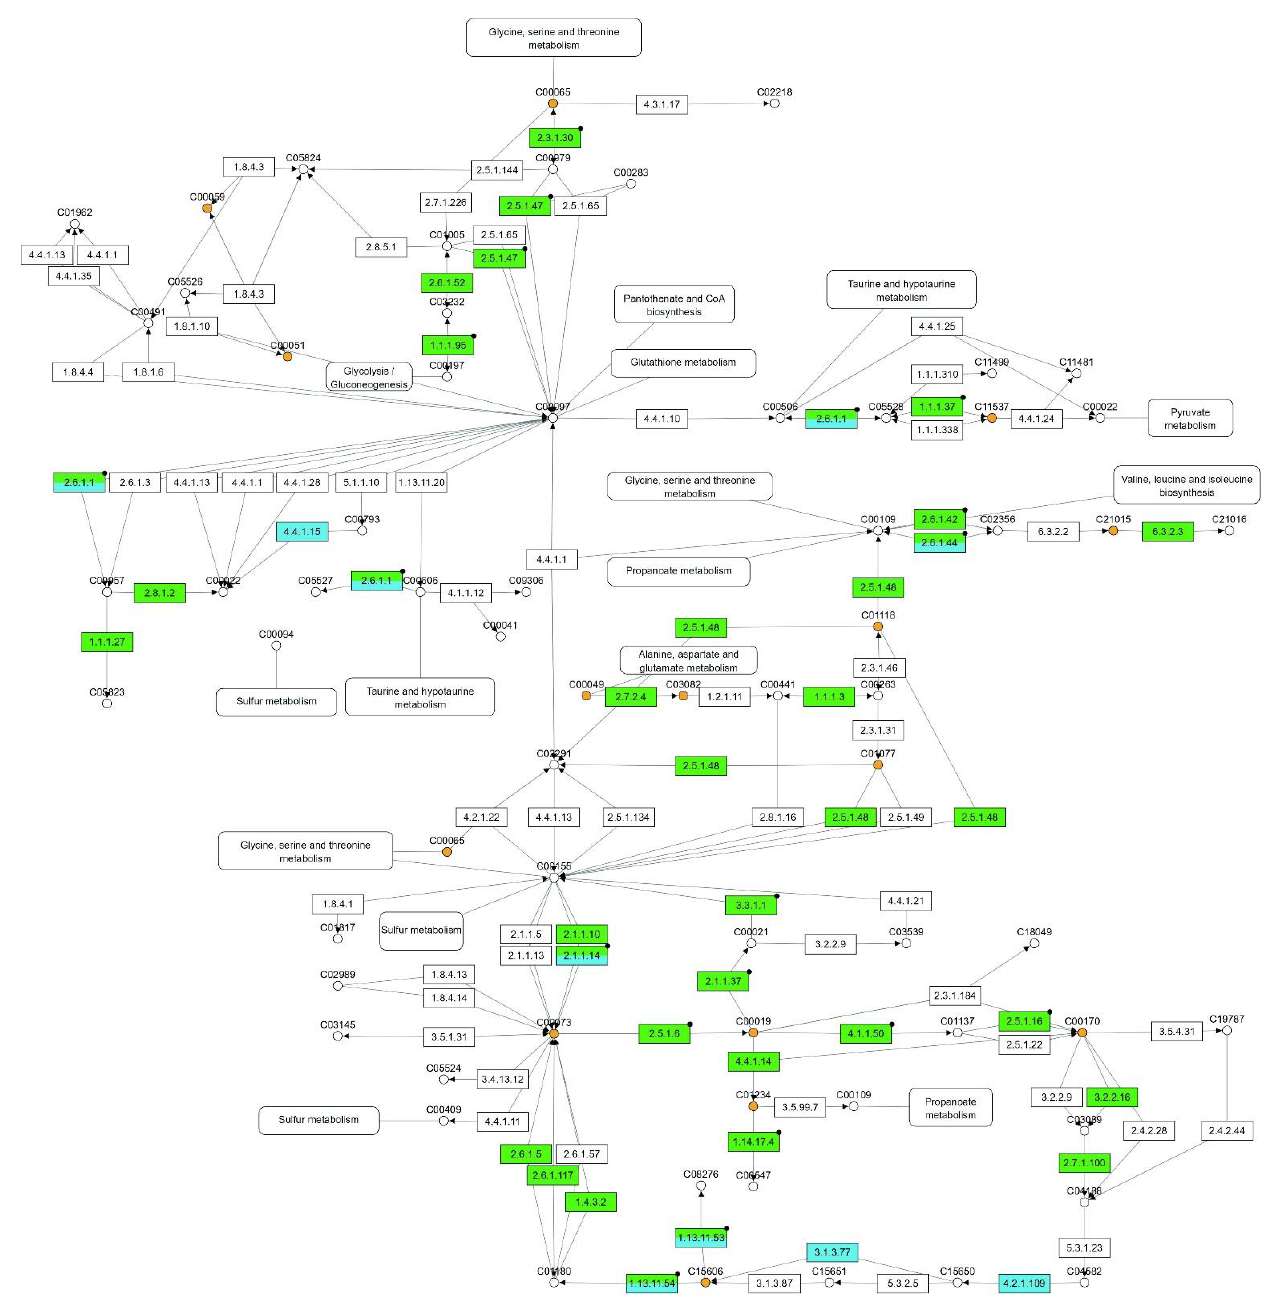
Figure 4. Enzymes (EC number) and metabolites (KEGG Compound number) from the Cysteine and methionine metabolism (map00270) pathway differentially expressed in the apical leaf of young oil palm plants submitted to drought stress. Metabolites differentially expressed are shown as orange circles, metabolites non-differentially expressed are shown as white circles, and enzymes non-differentially expressed are shown as white, and those differentially expressed are shown as green (from transcriptomics), as blue (from proteomics), and green/blue rectangles (from transcriptomics and proteomics).